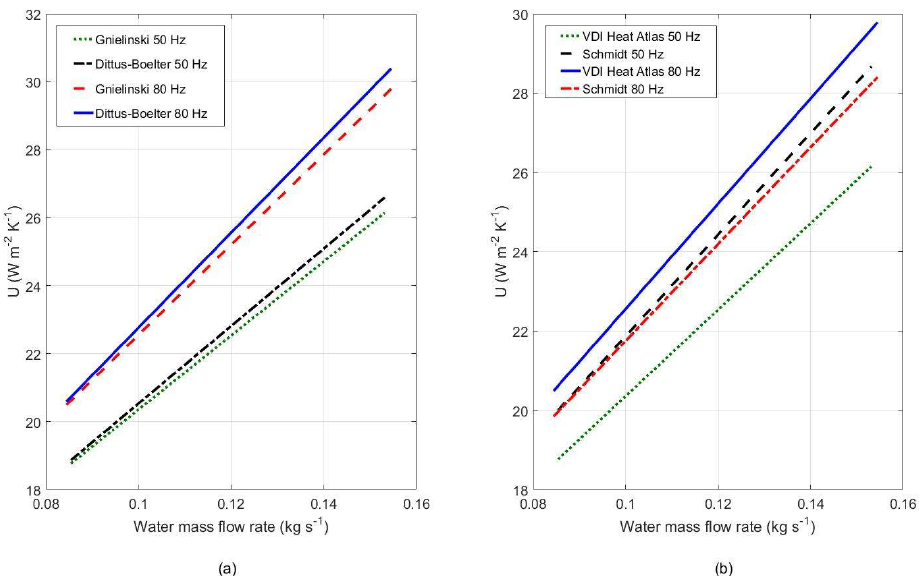
Figure 6. Comparison for 45 ◦ C water inlet temperature for ( a ) refrigerant-side heat transfer correlations; and ( b ) air-side heat transfer